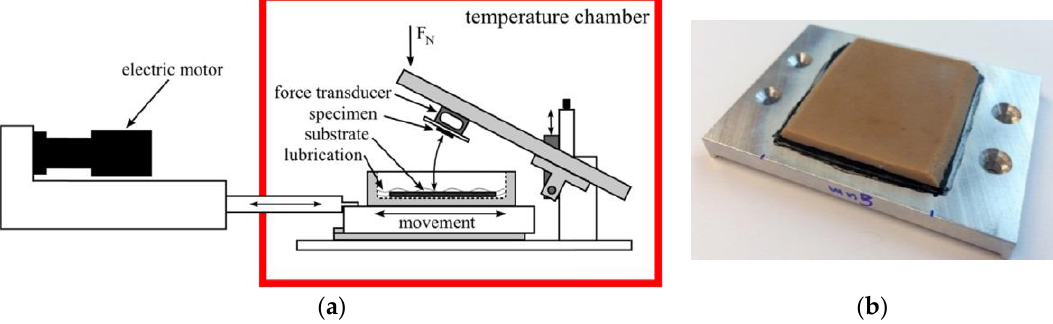
Figure 1. ( a ) Setup of the friction tester (schematically) reprinted from Reference [22] with permission from Elsevier and ( b ) an example test specimen.